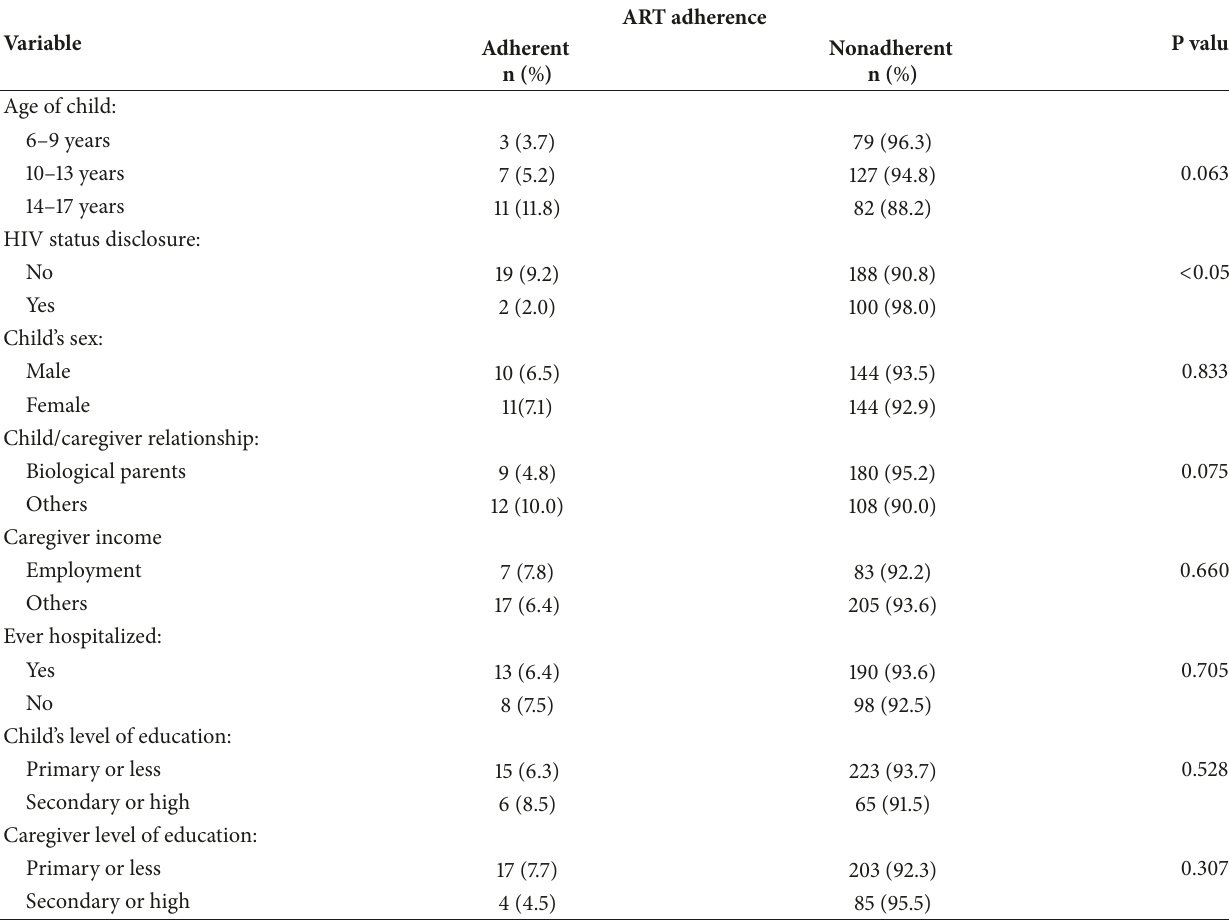
Table 4: Relationship between HIV status disclosure and ART adherence, among children between 6 and 17 years on antiretroviral therapy, in Southern Highlands Zone, Tanzania (N=309).